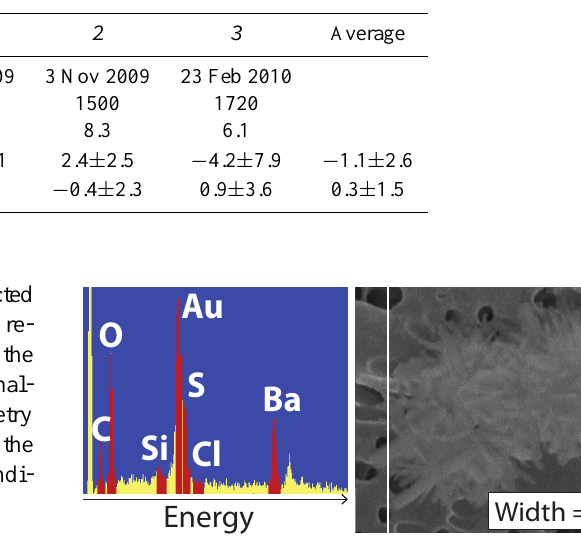
Table 1. Fractionation of 34 S/ 32 S and 33 S/ 32 S between two collectors in series during collection of H 2 SO 4 .